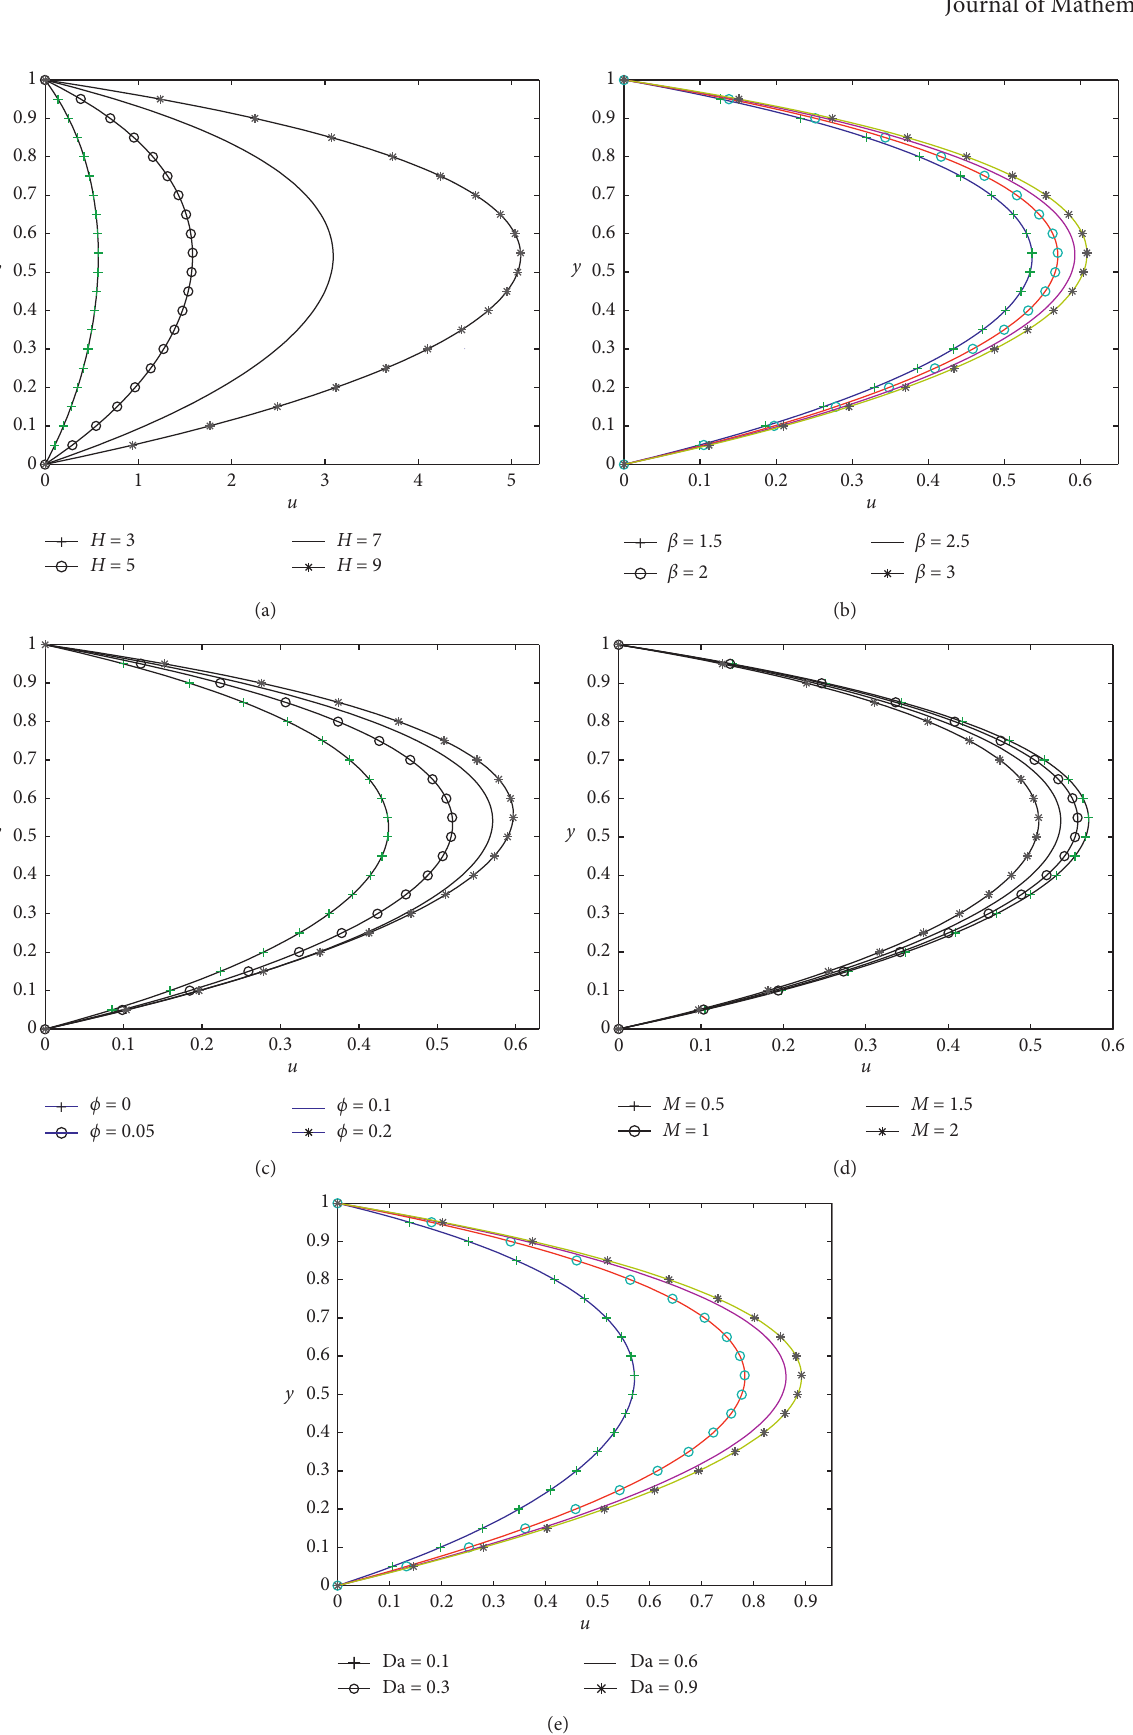
Figure 2: Velocity distribution for t � π /4 , ε � 0 . 01 , andRe � 1. (a) Effect of H when ϕ � 0 . 1 , M � 0 . 5 , Da � 0 . 1 , and β � 2. (b) Effect of β when ϕ � 0 . 1 , M � 0 . 5, Da � 0 . 1 , and H � 3. (c) Effect of φ when M � 0 . 5, Da � 0 . 1 , β � 2 , and H � 3. (d) Effect of M when ϕ � 0 . 1 , Da � 0 . 1 , H � 3 , and β � 2. (e) Effect of Da when ϕ � 0 . 1 ,M � 0 . 5 ,H � 3 , and β �